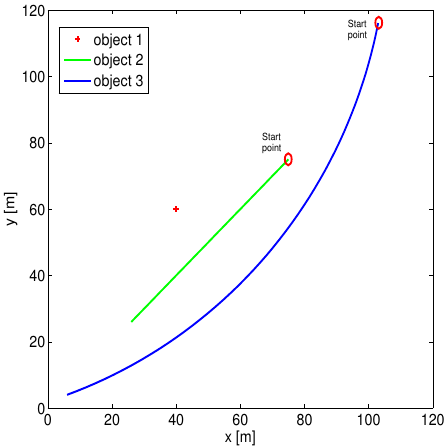
Figure 1. The trajectories of three objects.